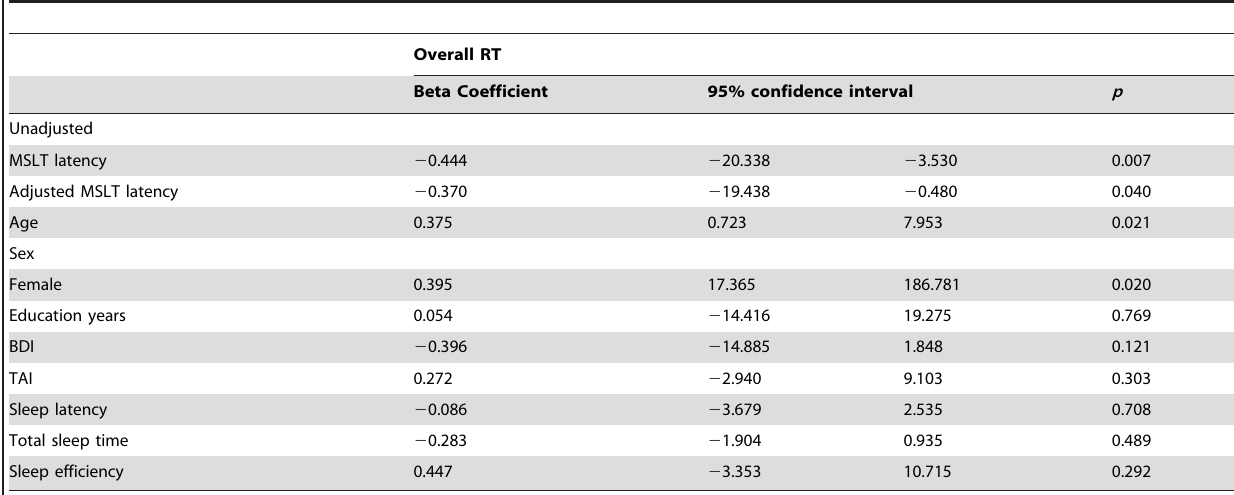
Table 4. Multiple Linear Regression Models predicting overall RT in primary insomnia